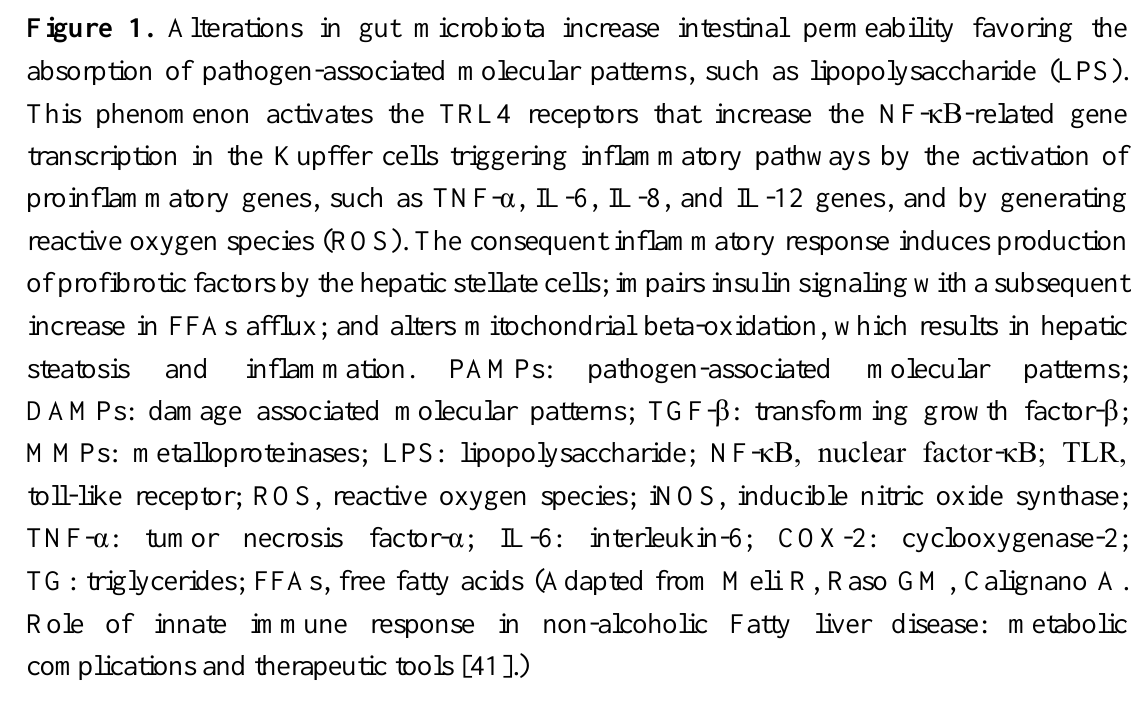
complications and therapeutic tools